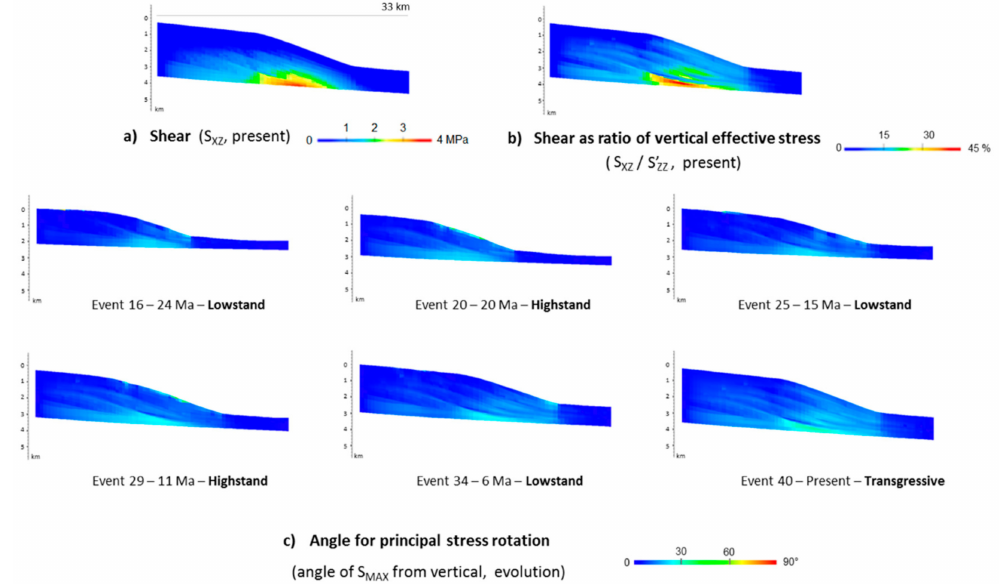
Figure 4. Shear and rotation of principal stresses simulated on the base case scenario. ( a ) present-day shear: absolute values; ( b ) present-day shear: ratios of vertical effective stress; ( c ) overview of the rotation of the principal stress system through time from six geological events; vertical exaggeration ×